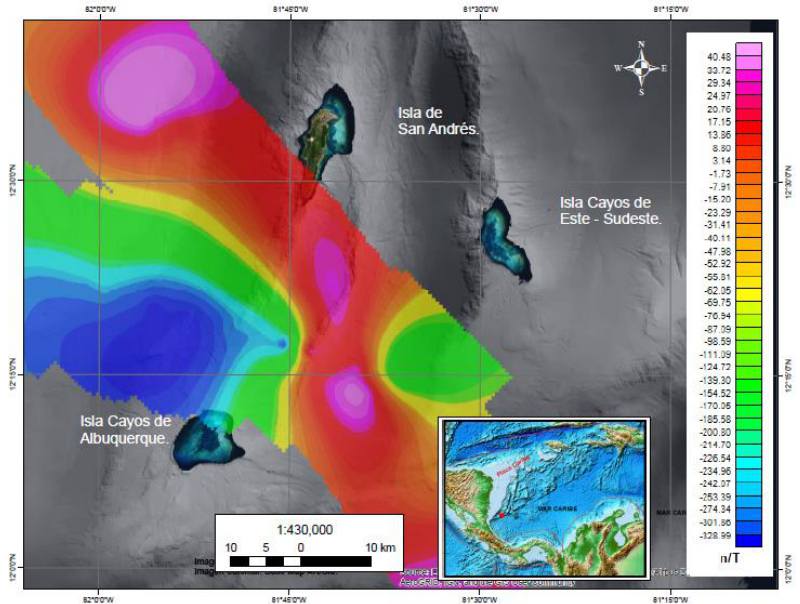
Figure 13. Geomagnetic surface of the total field, corresponding to the National Oceanic and Atmospheric Administration (NOAA) data.